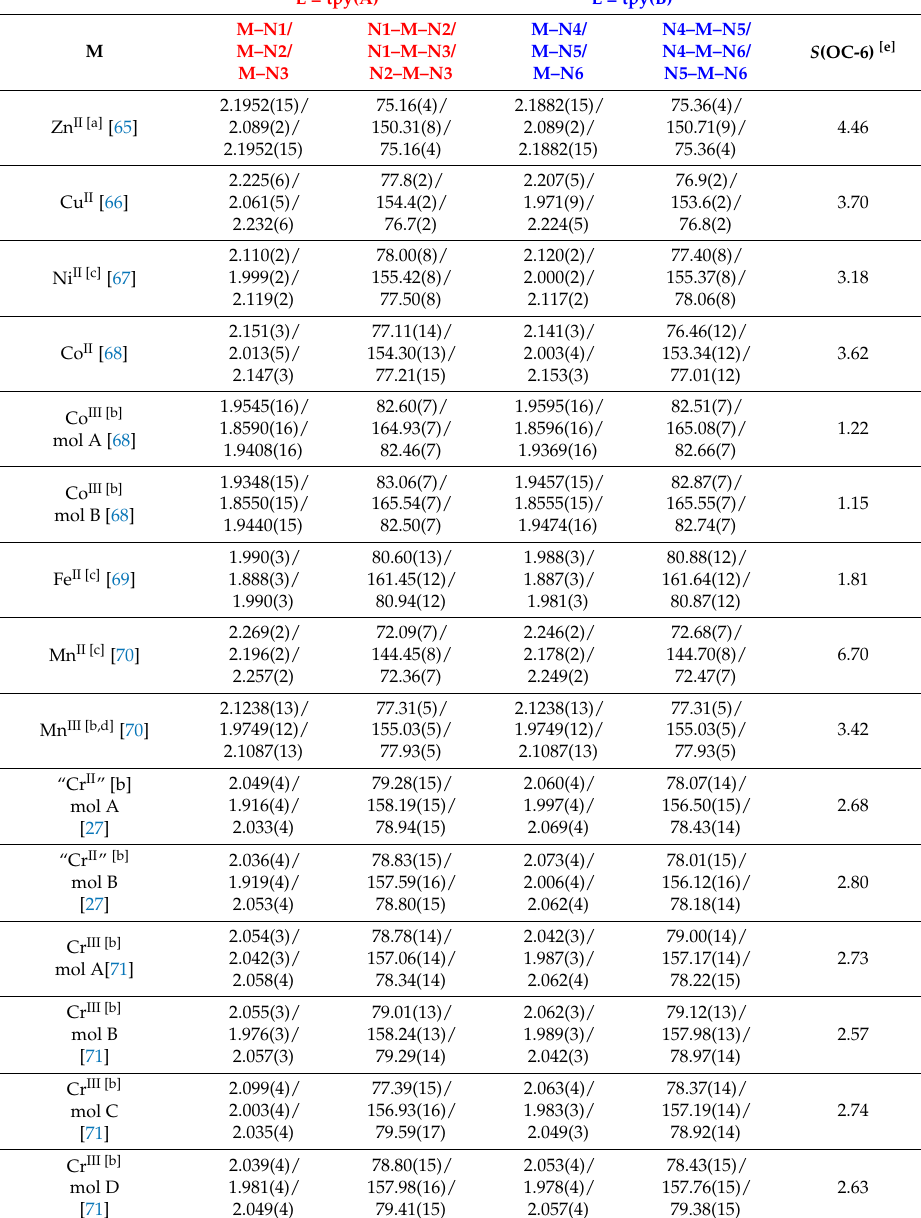
Table 2. Relevant metrical data of [M(tpy) 2 ] n + ions in the solid state; [BF 4 ] − salts if not indicated otherwise, distances in Å and angles in ◦ . Red and blue color code indicates the different tpy ligands. L =